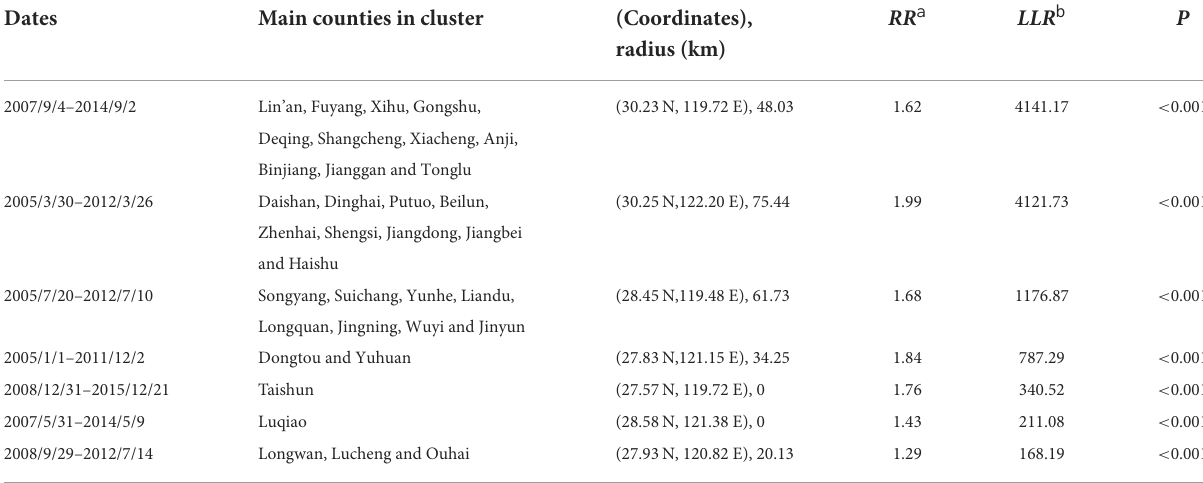
TABLE 2 Retrospective space–time scan analysis of syphilis cases in Zhejiang Province,